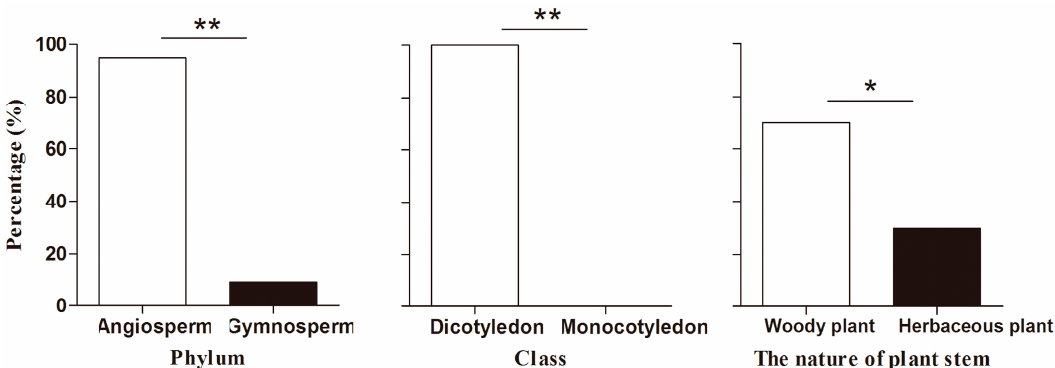
Figure 4. The characteristic of pollen source plants of migratory A. ipsilon during 2012–2014. Single asterisk (*) or double asterisks (**) indicates there was significant difference at the 5% or 1% level as determined by chi-squared test.